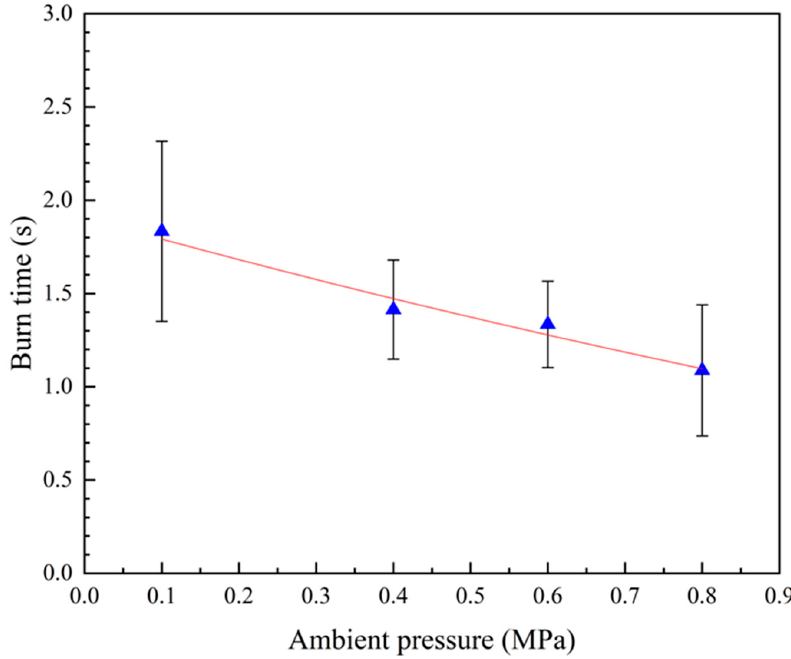
Figure 12. The burn time of single Al-Li alloy microparticles at different ambient pressures. The relationship between the burn time t b ( ms ) and the pressure p ( atm ) could be fitted and expressed as: